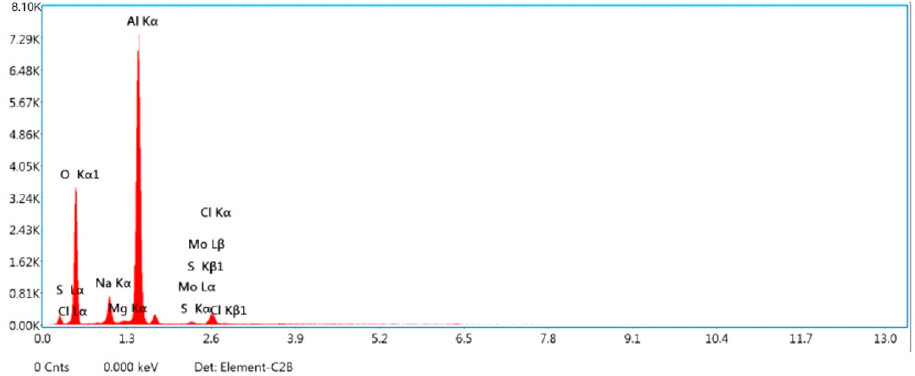
Figure 5 EDX image of machined surface under optimal